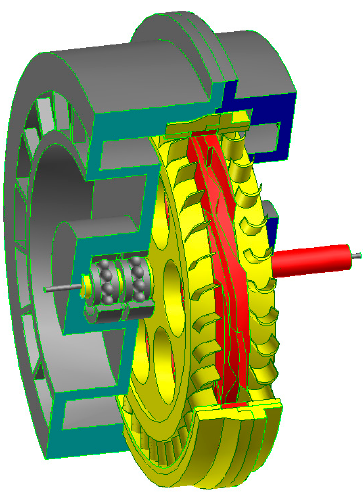
Figure 18. Visualization of a construction scheme for a double-rotor engine structure.